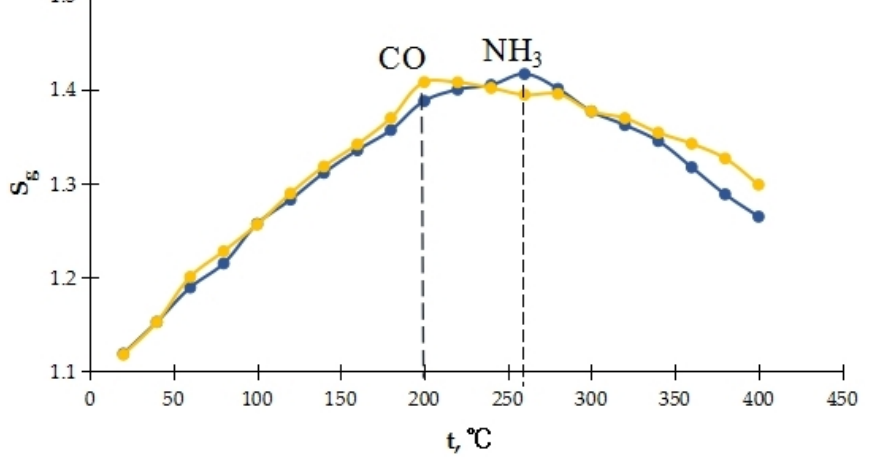
Figure 6. The gas-sensitive response of thin films obtained on the GaAs surface under the influence of the composition 80% Sb 2 O 3 + 20% Y 2 O 3 .